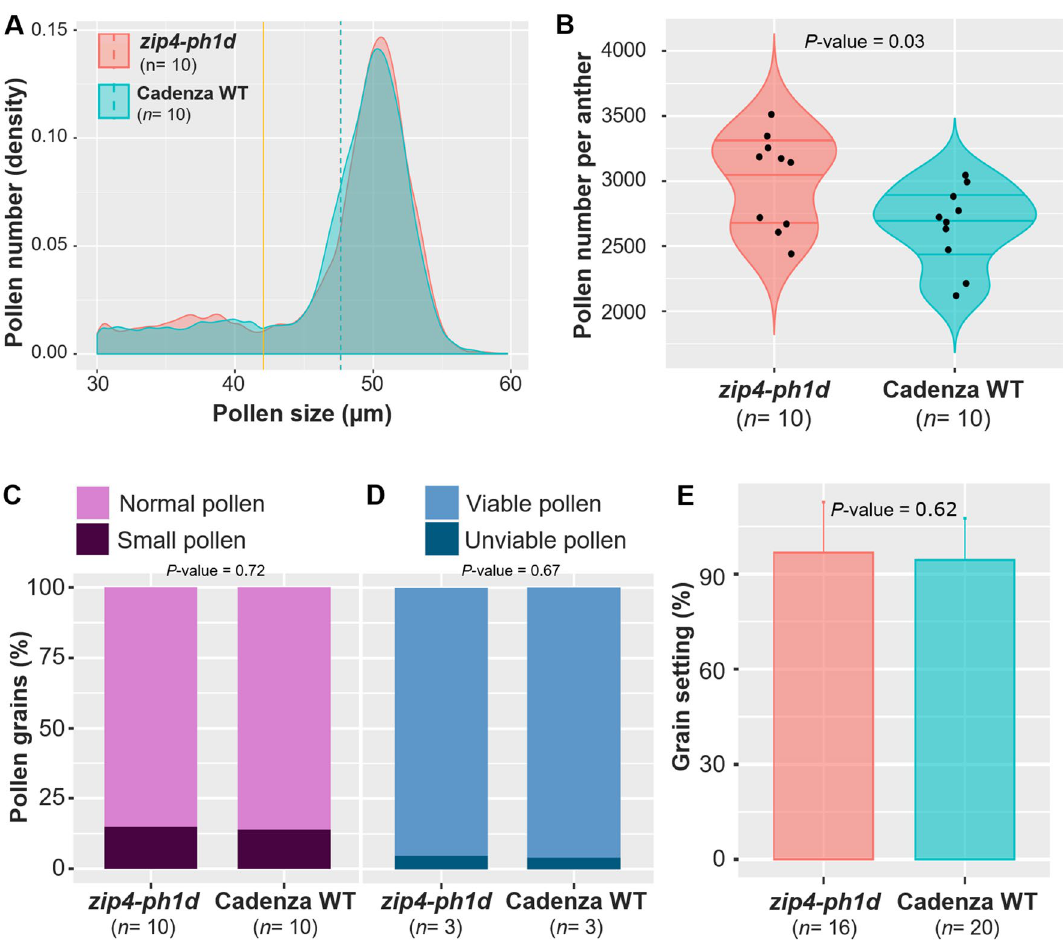
Figure 1. Pollen and grain setting analysis of the zip4-ph1d mutant and its wild type. ( A ) Density plot of differential pollen size distribution data collected by coulter counter (Multiziser 4e) showing similar pollen profiles in the zip4-ph1d mutant and its wild type (cv. Cadenza). Dotted lines indicate mean pollen grain size for each genotype. Yellow lines indicate the borderline between normal and small pollen for each genotype. ( B ) Violin plot showing number of pollen grains per anther in the zip4-ph1d mutant and its wild type. No significant differences in pollen number per anther were found between any of the mutants and their wild types. ( C ) Percentages of small pollen grains in each genotype. Pollen grains ≤ 42 µm are considered small. ( D ) Percentage pollen viability for each genotype, according to the Alexander staining method. More than 3000 pollen grains per genotype were scored after Alexander staining. ( E ) Grain setting (normalised grain number per spike) in the zip4-ph1d mutant and wild type control (cv. Cadenza) under CER growth conditions. n refers to the number of biological replicates used in each experiment. Error bar refers to the standard